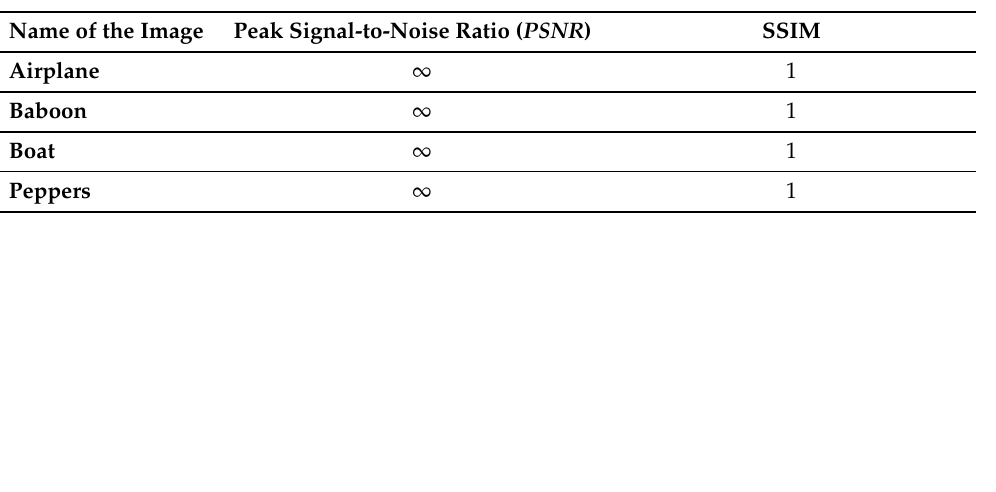
Table 3. PSNR and SSIM on airplane, baboon, boat and peppers